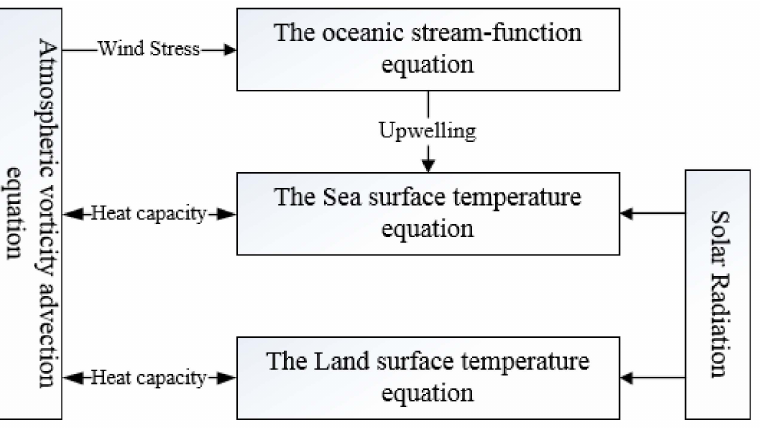
Figure 4. Coupled